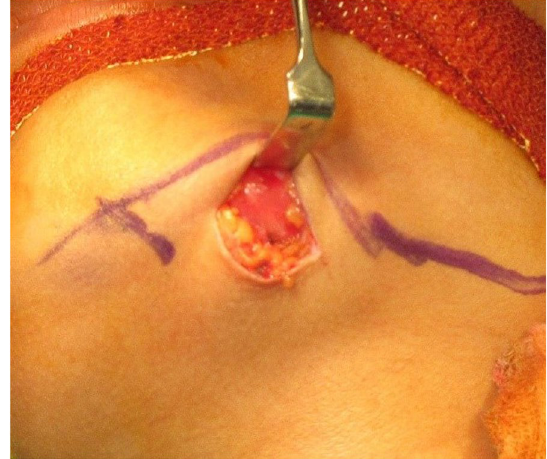
Fig. 1 Paramedian incision placed 2 cm away from the lower border of mandible